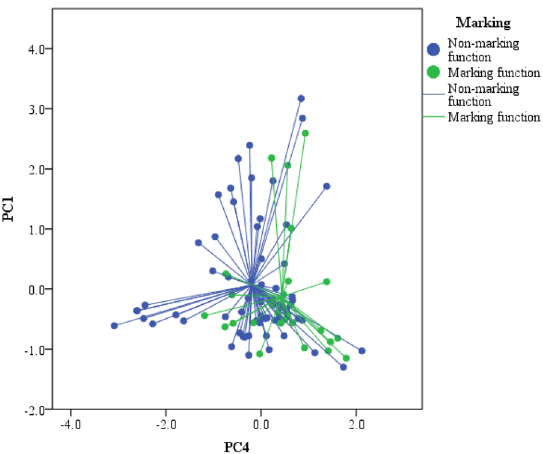
Figure 3. PC4 and PC1 individual scores extracted from the PCA made for relative proportions of lipophilic compounds in feces of adult Iberian wolves ( Canis lupus signatus ) depending on the presumably marking function (non-marking: blue; marking: green) of these feces in intraspecific communication. Individual points are related to the centroid for all samples of each marking